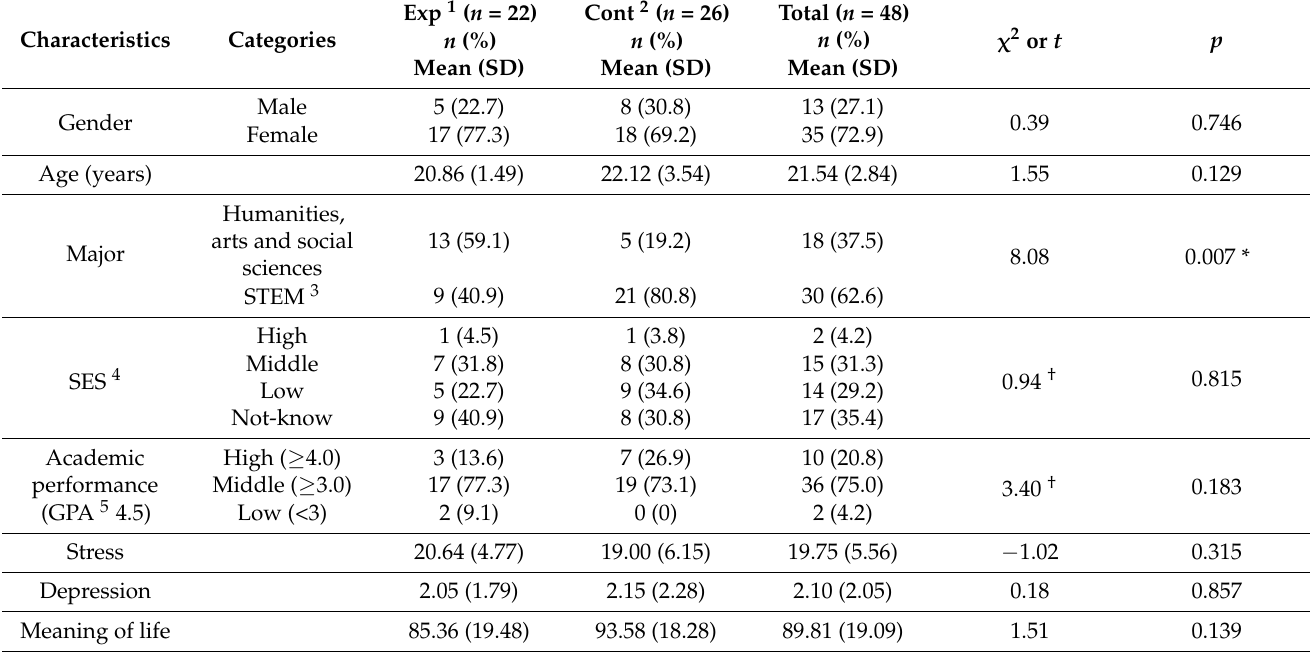
Table 2. Homogeneity test of participants’ characteristics and dependent variables ( n =